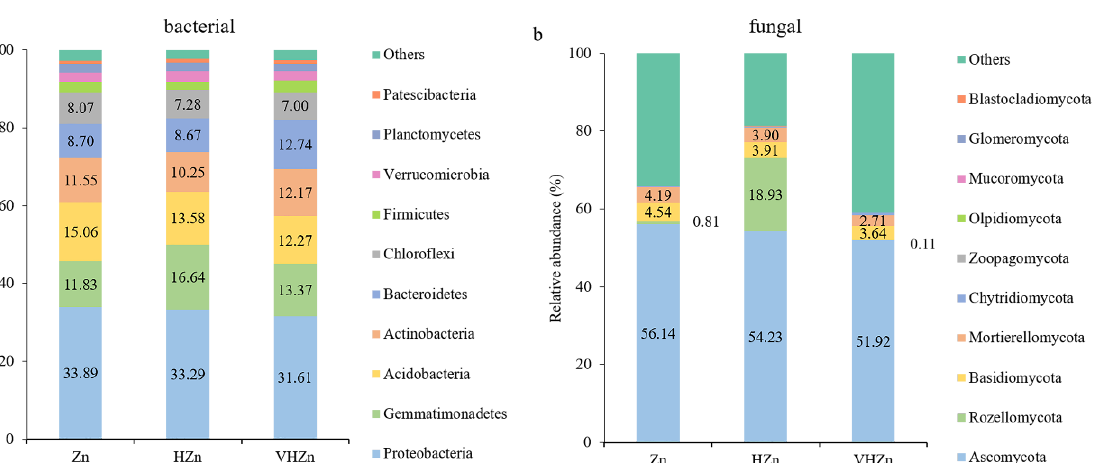
Figure 6. Hierarchical clustering heat maps of the bacterial ( a ) and fungal ( b ) communities in top 20 genera in rice rhizosphere soil with different levels of Zn (Zn: 10 mg . kg −1 soil; HZn: 200 mg . kg −1 soil; VHZn: 400 mg . kg −1 soil). 2.6. Fungal Communities in Rice Rhizosphere Soil ITS sequencing was used to reveal the effect of different levels of Zn on the alpha diversity of fungal communities in the rice rhizosphere soil. No significant ( p < 0.05) dif- ferences were observed in Chao 1, Observed_species, Shannon, Simpson, or Pielou_e in- dices under different Zn conditions, while only the Goods_coverage index significantly ( p < 0.05) increased under HZn condition compared to Zn condition. 657, 678, and 725 unique OTUs were found in the rice rhizosphere soil with Zn, HZn, and VHZn treatments, re- spectively. The PCoA analysis showed that fungal communities from different Zn treat- ments were distinct along both X -axis and Y -axis.